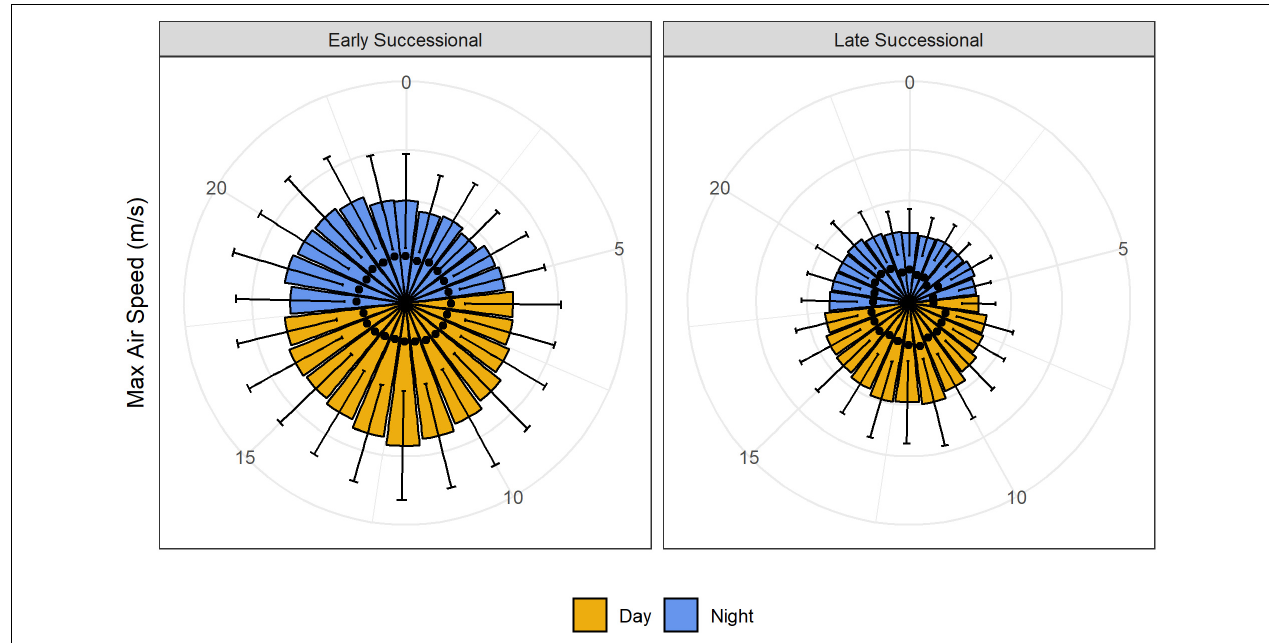
FIGURE 3 | Maximum air speeds in meters per second at our early and late successional sites over the diel cycle. Black dots represent turbulence